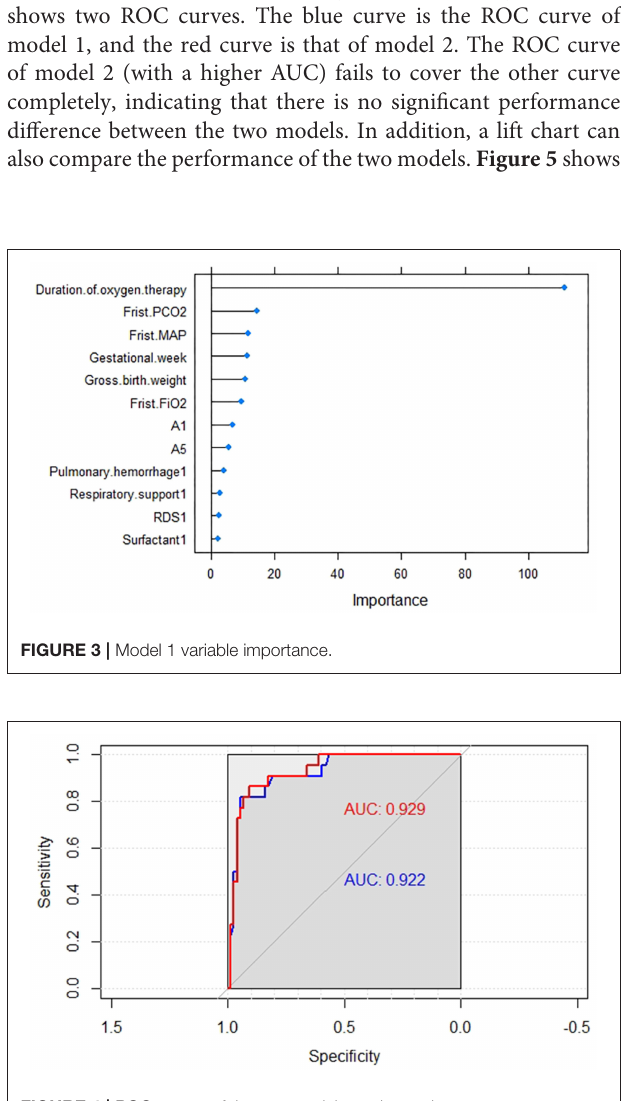
FIGURE 4 | ROC curves of the two models on the testing set.